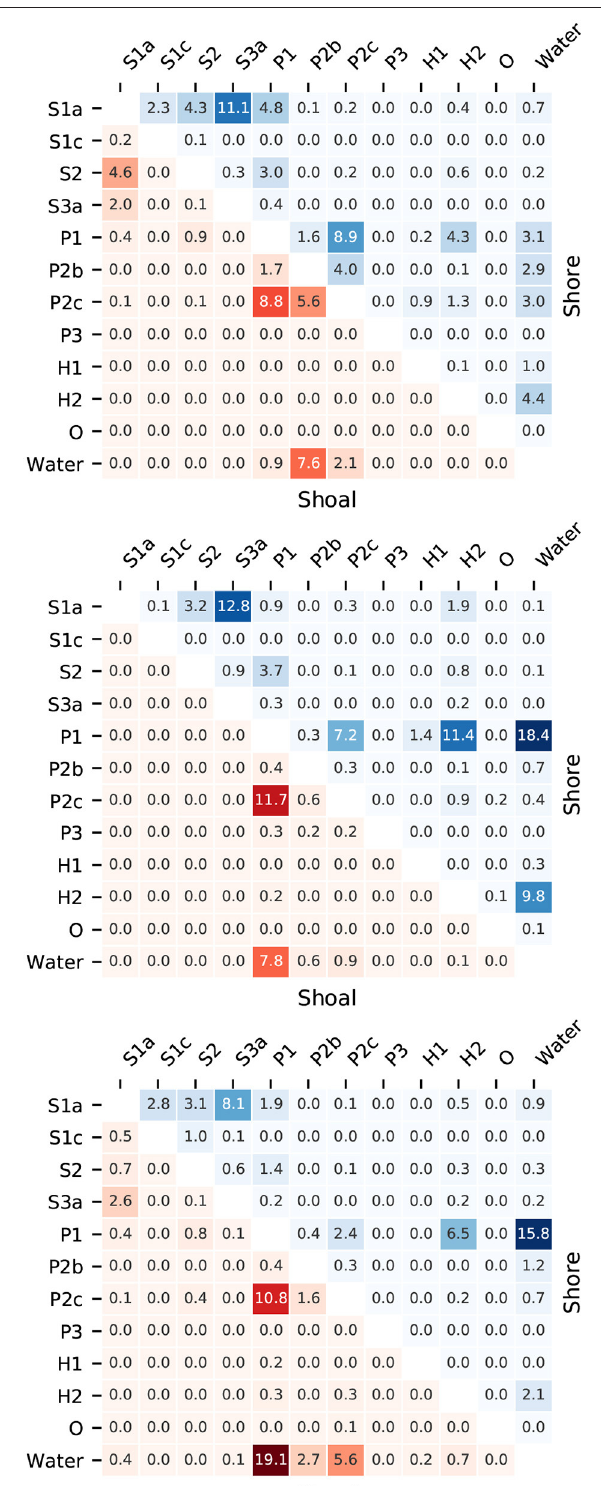
FIGURE 9 | for the Western Scheldt (top) , Eems-Dollard (middle) , and Eastern Scheldt (bottom) . For explanation of classes see Table 2 . The colors are linearly scaled with the numbers. The sum of each entire matrix is 100%.